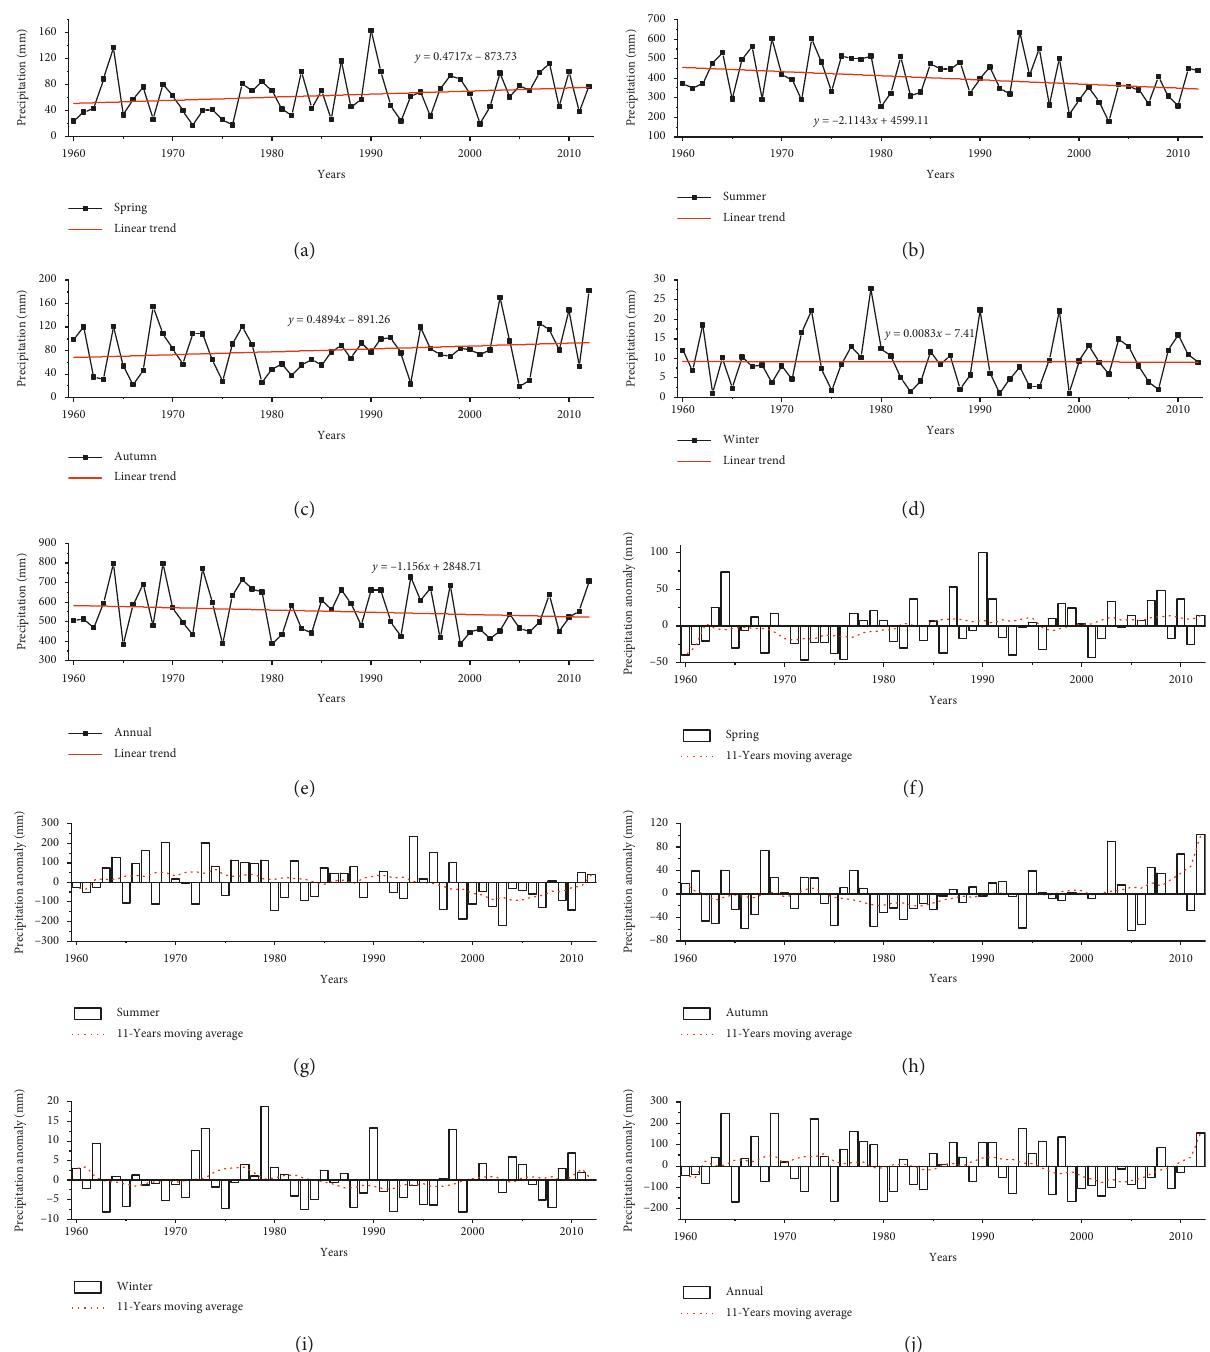
Figure 3: Time series of precipitation and anomaly in the Beijing metropolitan area from 1960 to